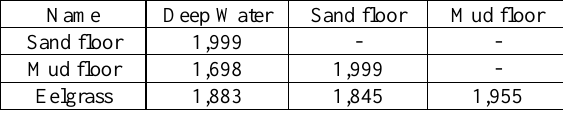
J-M distance computed with the class training areas delineated from the Pix4D RGB mosaic of Shediac Bay, for each class (eelgrass, deep water, sand, and unknown dark areas).